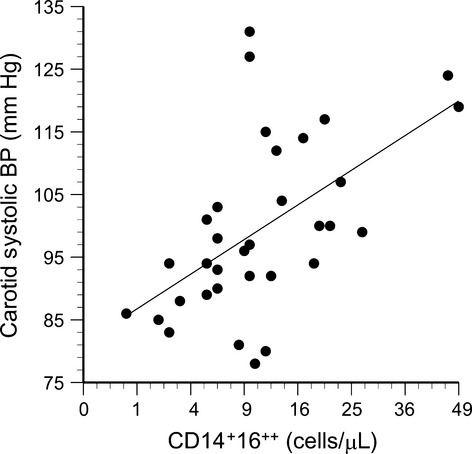
Carotid systolic blood pressure plotted as a function of the number of circulating CD14+16++ cells (R = 0.58, P = 0.0008).